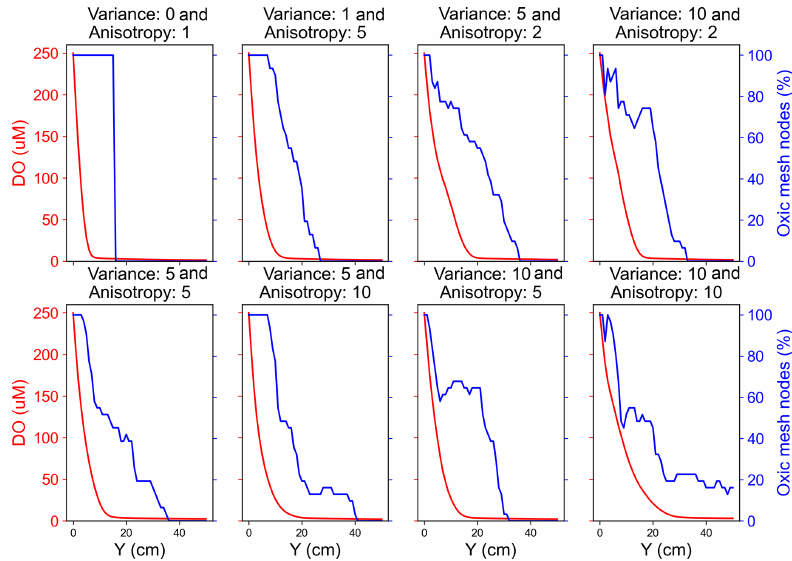
Figure 3. Comparison of flux-averaged DO concentration and percent of oxic mesh nodes (i.e. cells with DO concentration > 3µM) along the flow direction in a medium flow